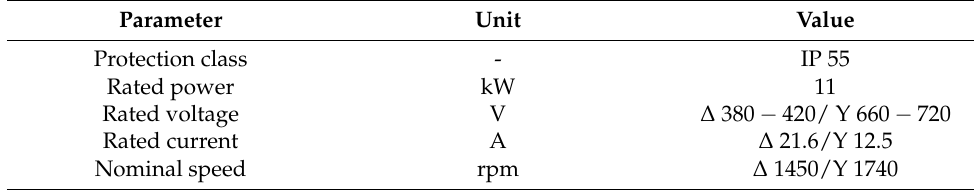
Table 4. Technical parameters of an asynchronous electric motor (EM).